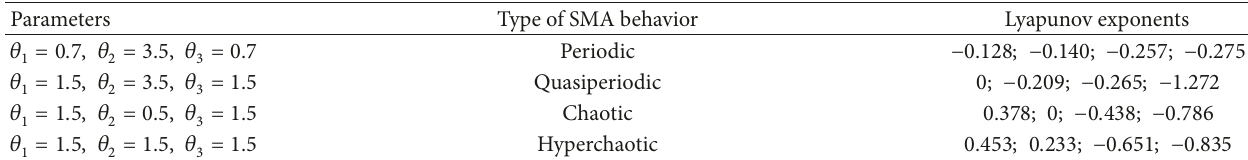
Table 1: Types of SMA